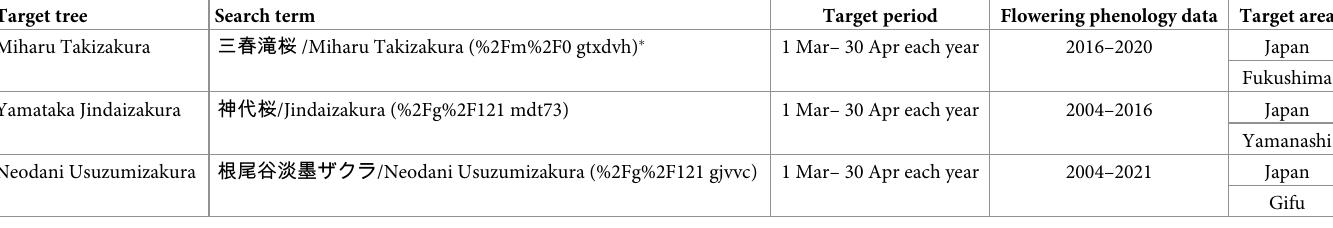
Table 1. Query terms used to search Google Trends and flowering phenology data. Target tree Search